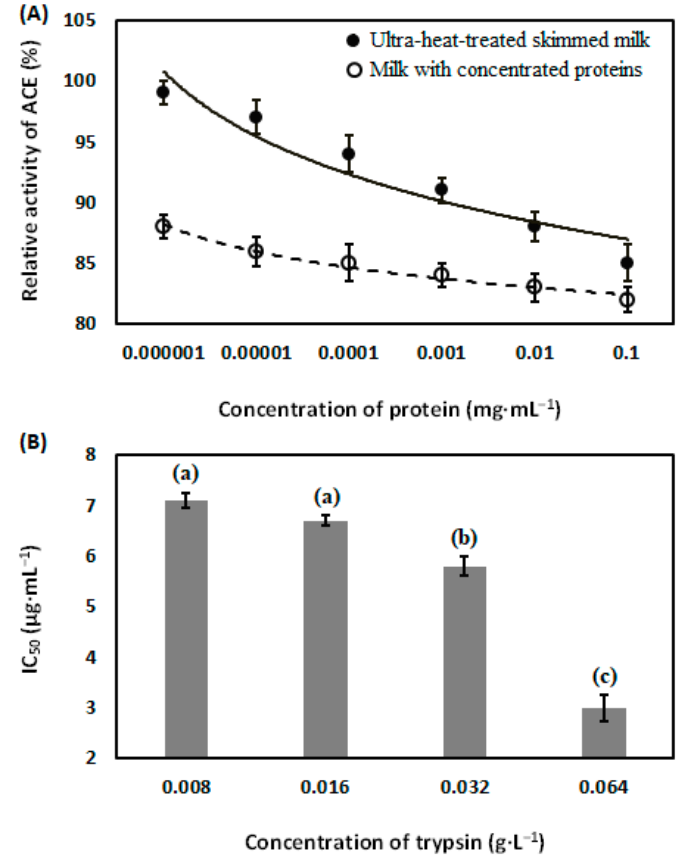
Figure 8. Angiotensin converting enzyme (ACE)-inhibitory activity of ultra-heat-treated skimmed milk and milk with concentrated proteins ( A ), and values of IC 50 in milk with concentrated proteins after enzyme treatment ( B ). Results are represented by mean value with standard deviation ( ± values). In superscript, dissimilar alphabet represents the significant difference between results, evaluated by the Tukey’s post hoc method.